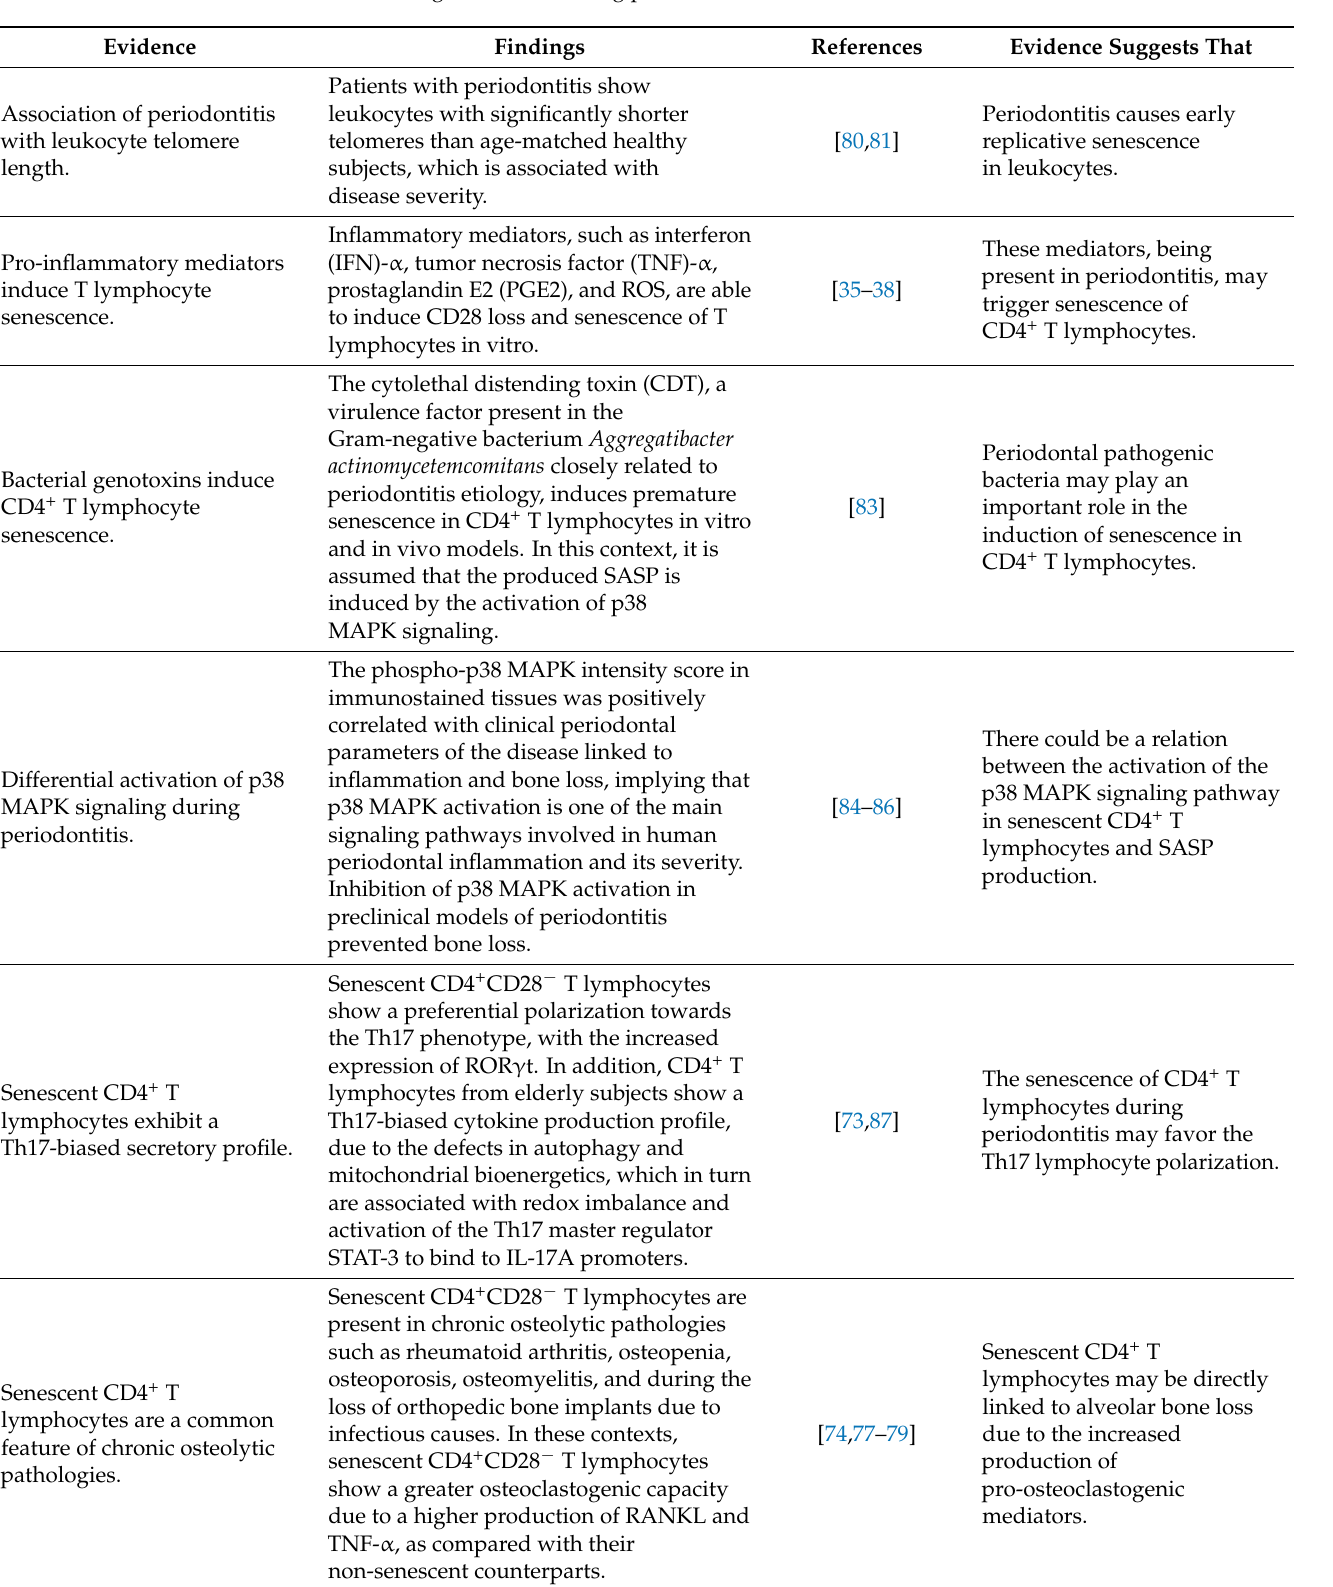
Table 1. Evidence supporting the possible role of CD4 + CD28 − T cell senescence as a potential driver of Th17/Treg imbalance during